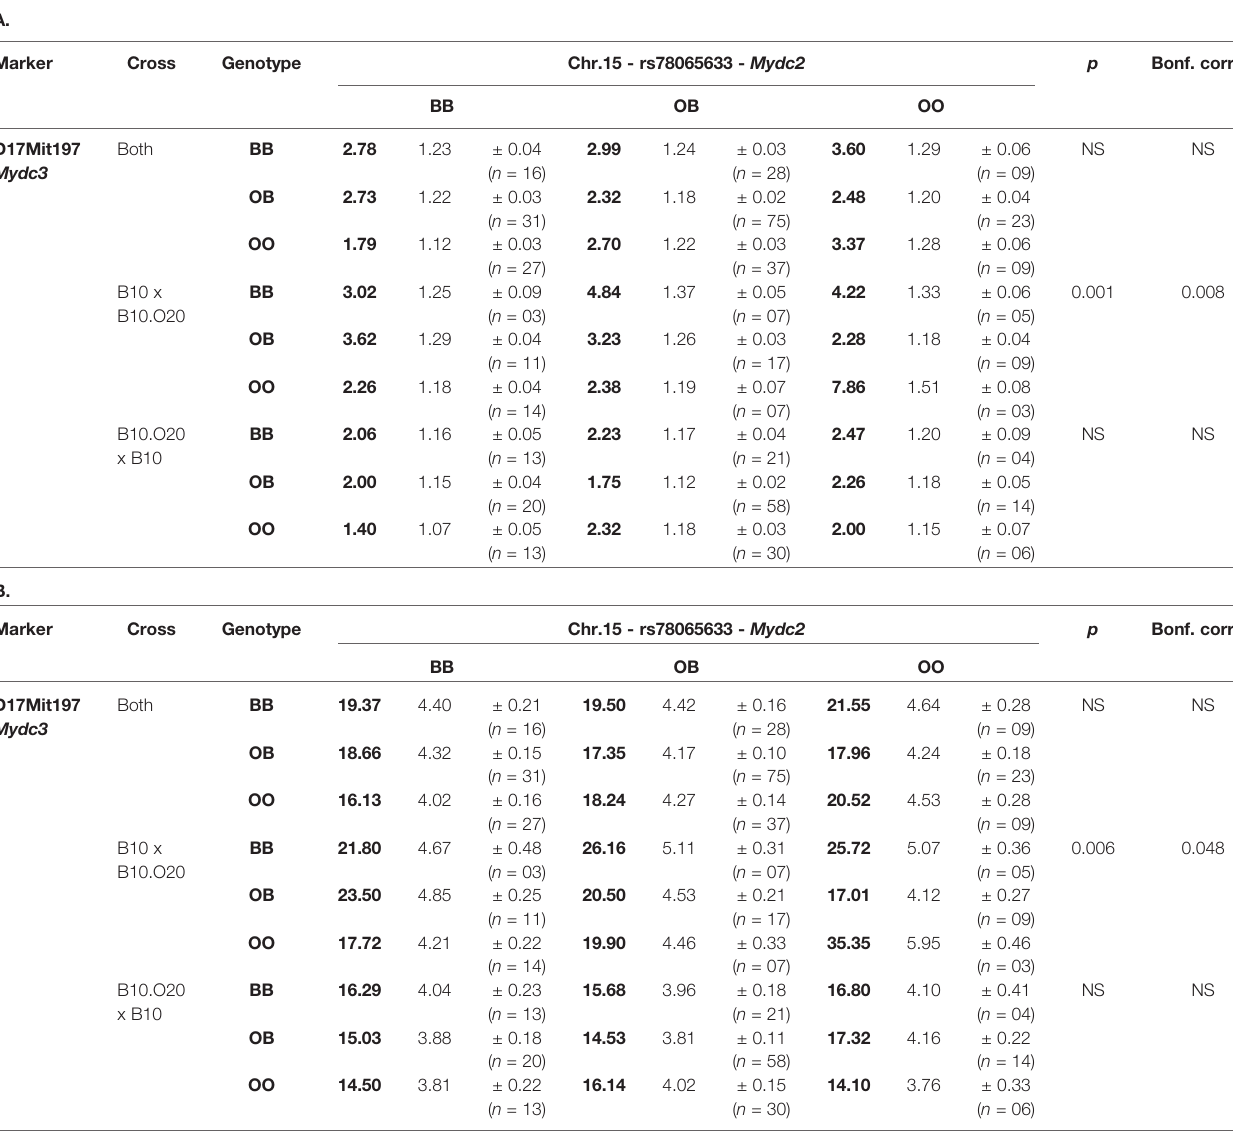
Second row and column indicate the genotype of the corresponding locus. In order to obtain normal distribution required for ANOVA, the following transformations were used: CD11b + Gr1 + (% in spleen homogenates) - power of 5; % of Gr1 + Siglec-F - cells from CD11b + cells – power of 2. Transformed means ± SEM are shown next to average non-transformed mean values in bold. n indicates the number of